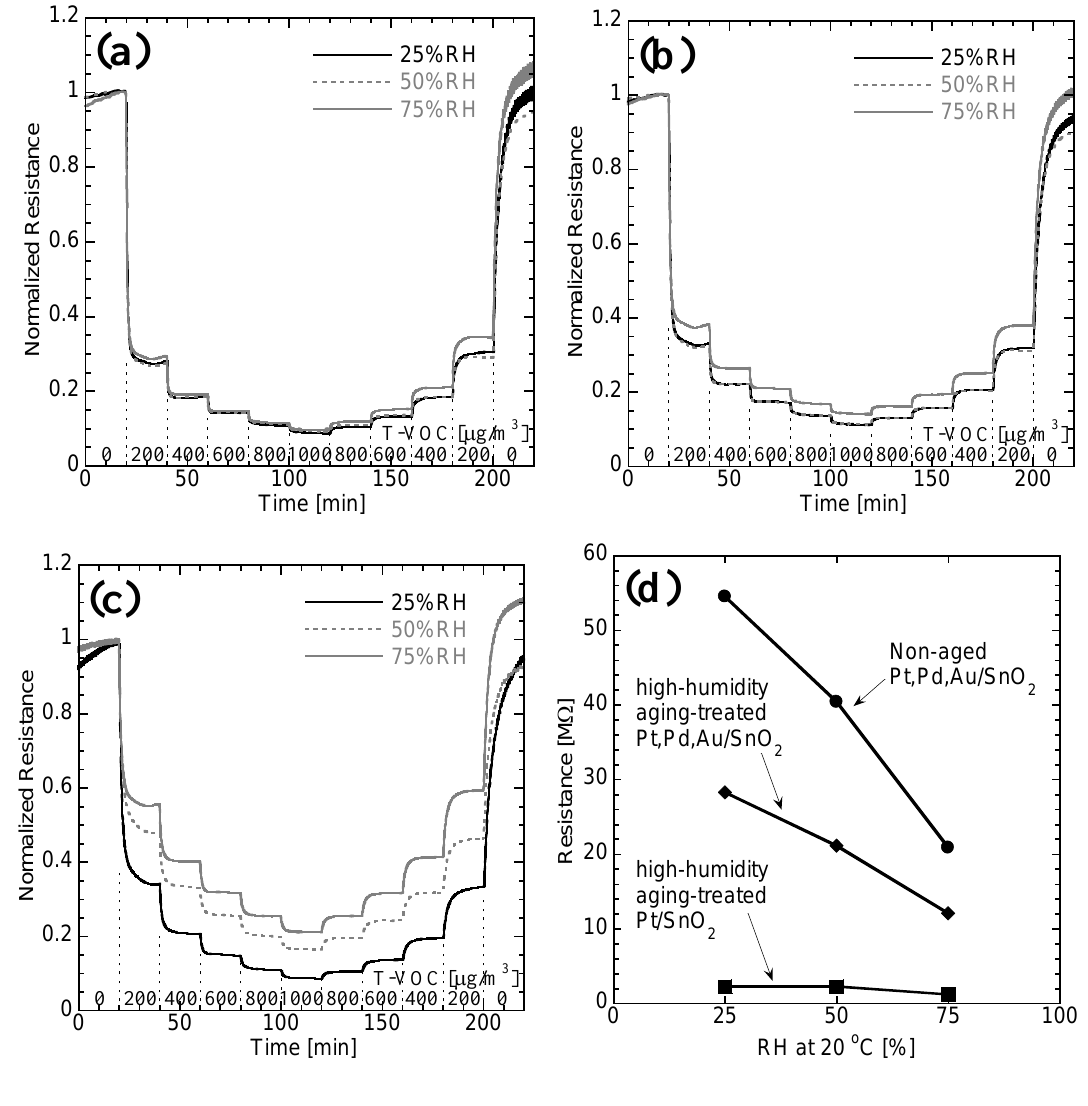
Figure 2. Normalized resistance profiles of (a) high-humidity aged Pt,Pd,Au/SnO , 2 (b) non-aged Pt,Pd,Au/SnO , and (c) high-humidity aged Pt/SnO in humid air with several 2 2 concentrations of T–VOC test gas at 300 °C. The black, gray-dashed, and gray lines indicate the normalized resistance of elements in 25, 50, and 75%RH at 20 °C, respectively. The normalization of resistance is based on the resistance at 20 min. Panel (d) shows the base resistance for the normalization, i.e. , the real resistances of all elements in 0  g/m 3 of T–VOC test gas condition at 20 min in Figure 2a, 2b and